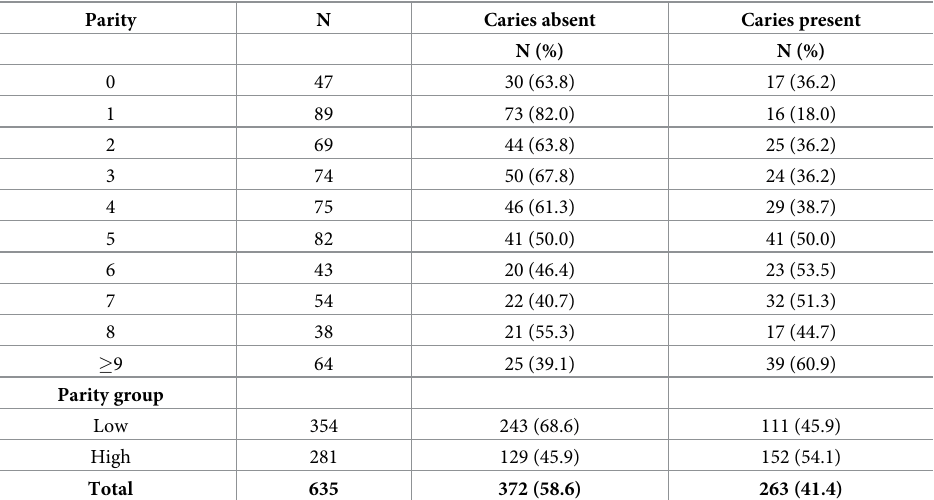
Table 1. Frequency of caries by parity and parity